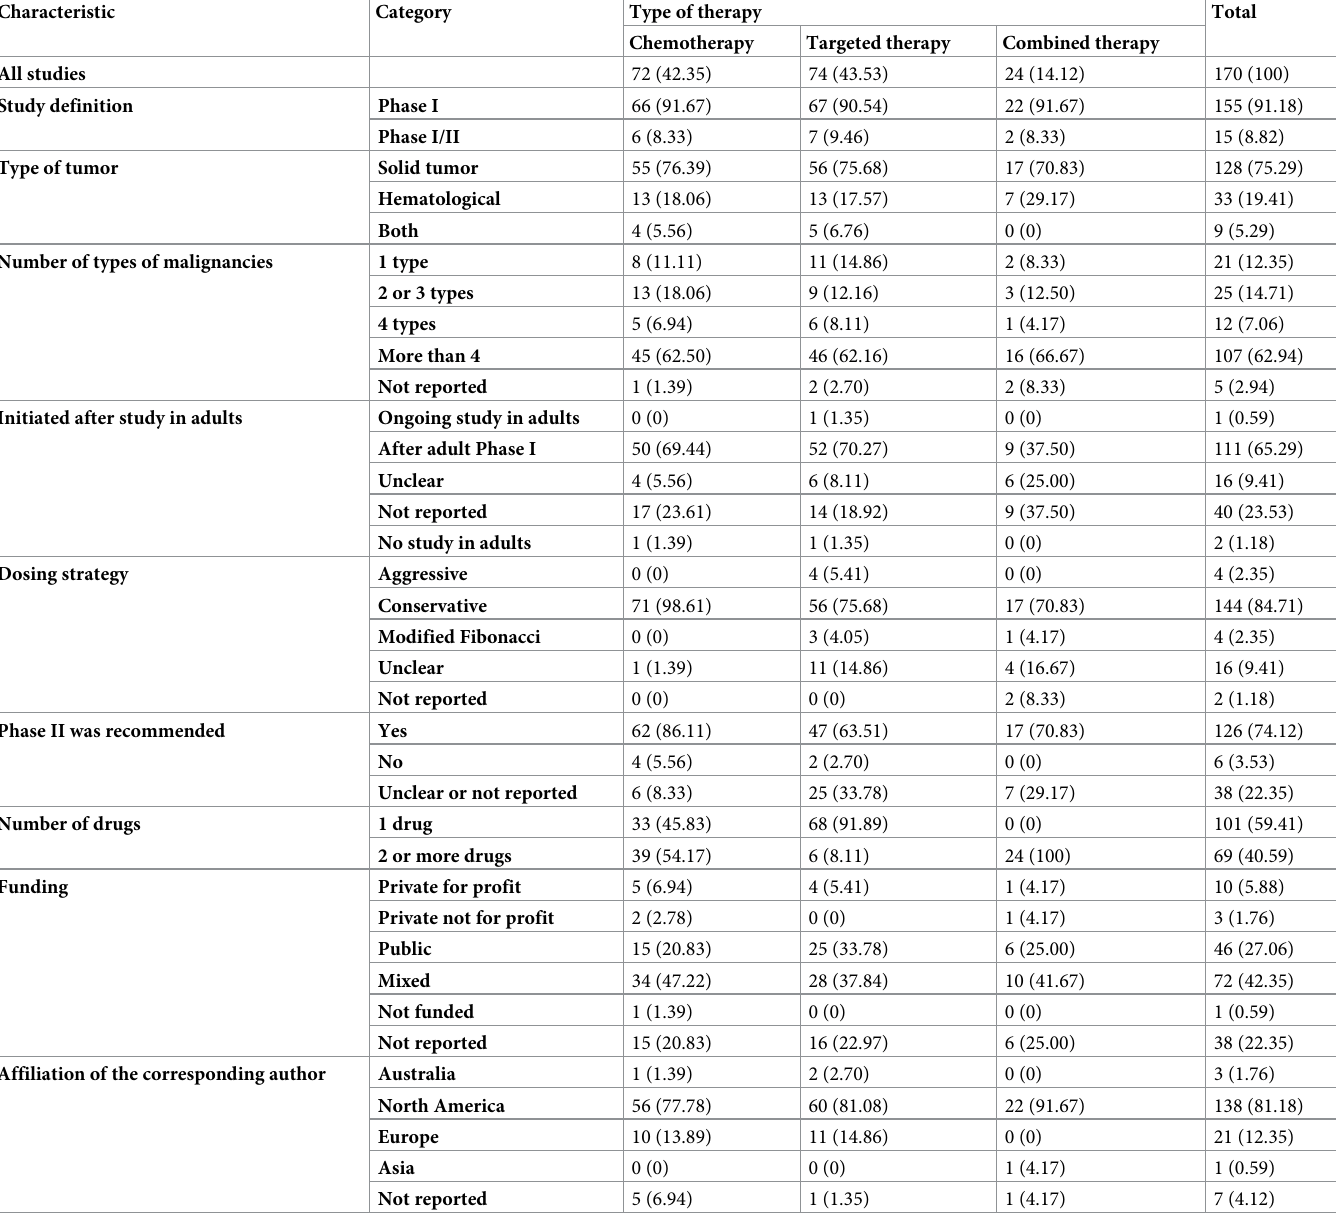
Table 1. Characteristics of